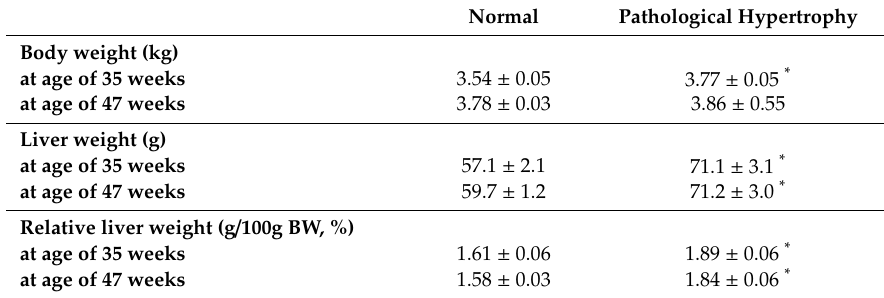
Figure 6. E ff ect of dietary 25-OH-D3 supplementation on blood pH, gas parameters, and cardiac HIF-1 α expression of broiler hens provided with restricted or ad libitum feed intake. At age of 29, 35, and 47 weeks, 4, 7, and 7 hens from each group were randomly selected for tissue collection. Collected blood samples were used for pH and gas parameter analysis (Panels A – D ). Of the hearts collected at 35 and 47 weeks, 4 hearts from each group were used for HIF-1 α expression through Western blot study (Panel E , n = 4). The remaining 3 hearts were used for histological studies. Results of Western blot studies were normalized to β -actin and expressed as ratios relative to R- hens at 29 weeks. *; significant di ff erence by ad libitum feeding (vs. corresponding R hens, p < 0.05). + ; significant di ff erence by 25-OH-D3 inclusion (vs. R or Ad hens, p < 0.05). R; restriction, Ad; ad libitum, 25-OH-D3; 25-hydroxycholecalciferol, HIF-1 α ; hypoxia-inducible factor 1 alpha. Table 3. Body composition, hepatic, plasma TG content, incidence of arrhythmic ECG pattern, and blood gas parameters of feed-restricted broiler breeder hens with normal or pathologic cardiac hypertrophy at